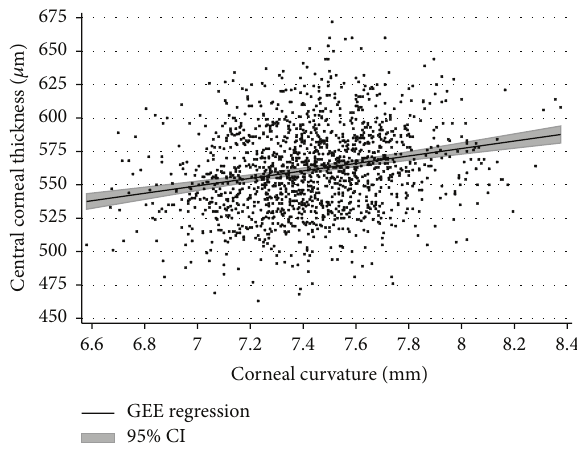
GEE regression 95% CI Figure 2: Relationship of central corneal thickness as determined with SD-OCT and corneal curvature: an increase of central corneal thickness (CCT) is associated with a flatter corneal curvature (CC). The correlation coefficient is 𝑟 = 0.20 ( 𝑝 < 0.001 ) and the regression equation is CCT (in 𝜇 m) = 354 + [27.9 ∗ CC (in mm)].